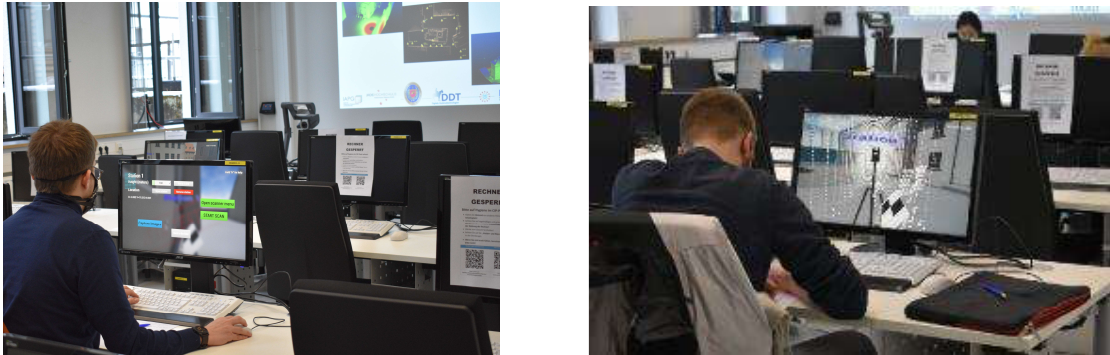
Figure 3: Simulator testing by the student group in the computer cluster. Left: The student is setting up the 3D scanner with specific settings. Right: The student is filling is taking notes about his observations during user testing. On-screen is an ongoing virtual scan with the BLK360 terrestrial laser scanner. (Photos: T.